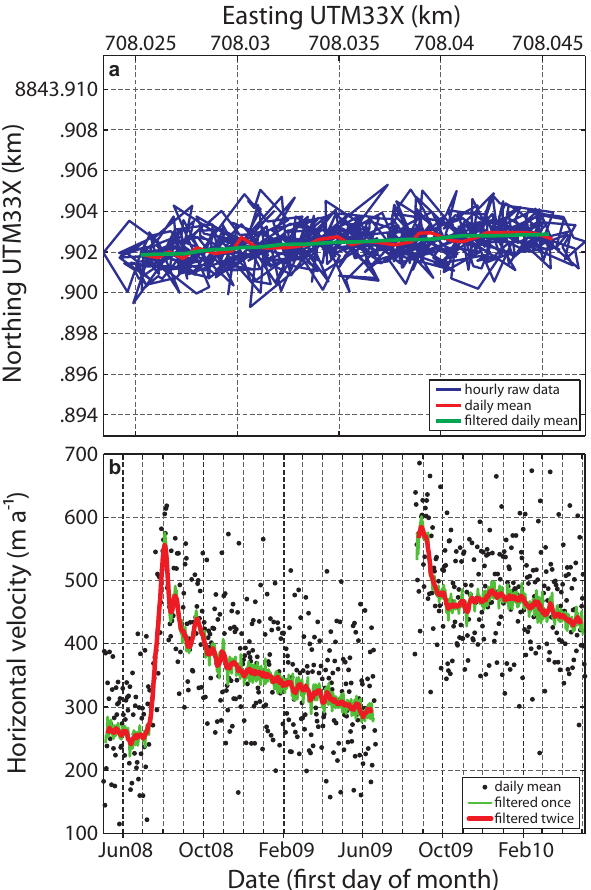
Fig. 3. Processing of continuous GPS observations. Positioning of stake Basin-3#2 during June 2008 (a) : hourly GPS raw-data (blue), daily-mean values (red) and after application of a 7 day running mean (green). Flow velocities derived from displacement of GPS positions (b) , utilizing daily mean (black scatters) or 7 day filtered positions with/without additional 7 day filtering of the computed velocities (red/blue solid